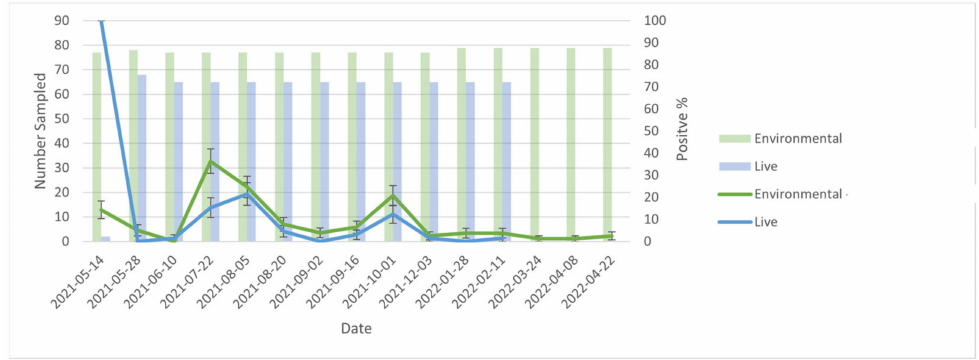
Figure 1. Comparison of environmental and live samples from 2021-05-14 to 2022-04-08. No live samples occurred after 2022-02-11 because the farm was depopulated.